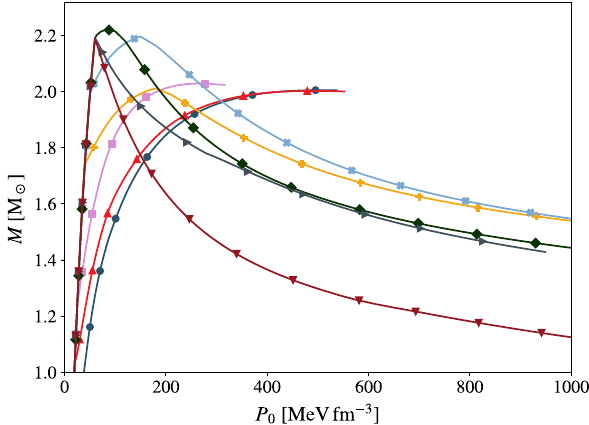
Fig. 2 MassasafunctionofthecentralpressurefortheEOSspresented in Fig.